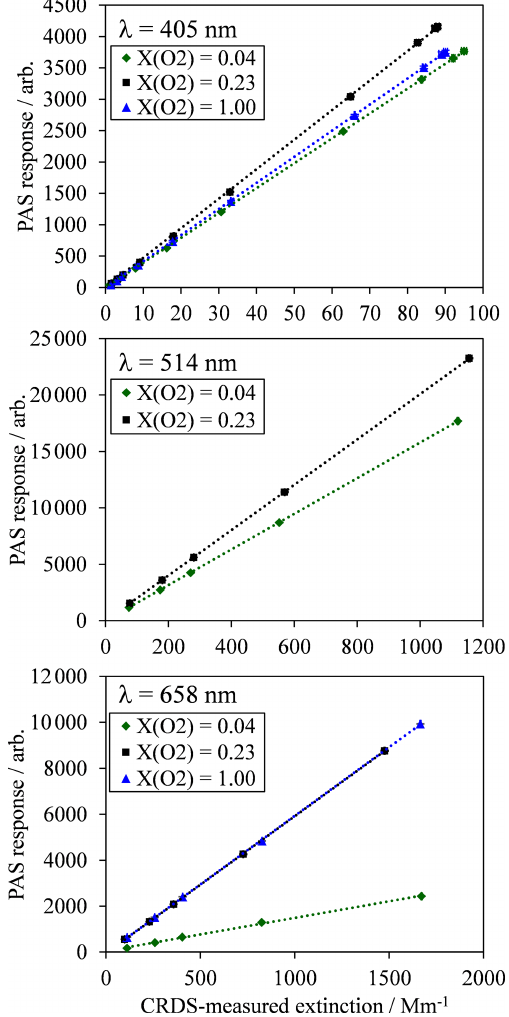
Figure 2. For each PAS channel, example calibration measurements of PAS response variation with CRDS-measured extinction for an analyte of ozone gas. Each plot shows typical calibration data for ozone gas in bath gases composed of a mixture of N 2 and O 2 , with O 2 mole fractions of 0.04 (near-pure N 2 ), 0.23 (ambient air compo- sition) and 1.0 (pure O 2 ). All data points include error bars corre- sponding to 1 standard deviation in the measured PAS response or extinction, although these error bars are not visible on the plot scales because of the low variance in the measurements. Dashed lines rep- resent straight line fits to the measured data, with the fit constrained such that the intercept is